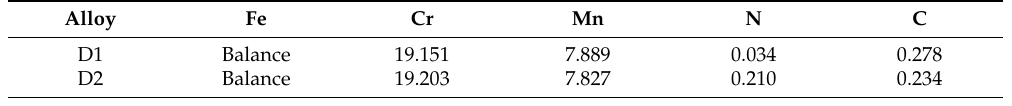
Table 1. Chemical compositions of the investigated alloys (in wt